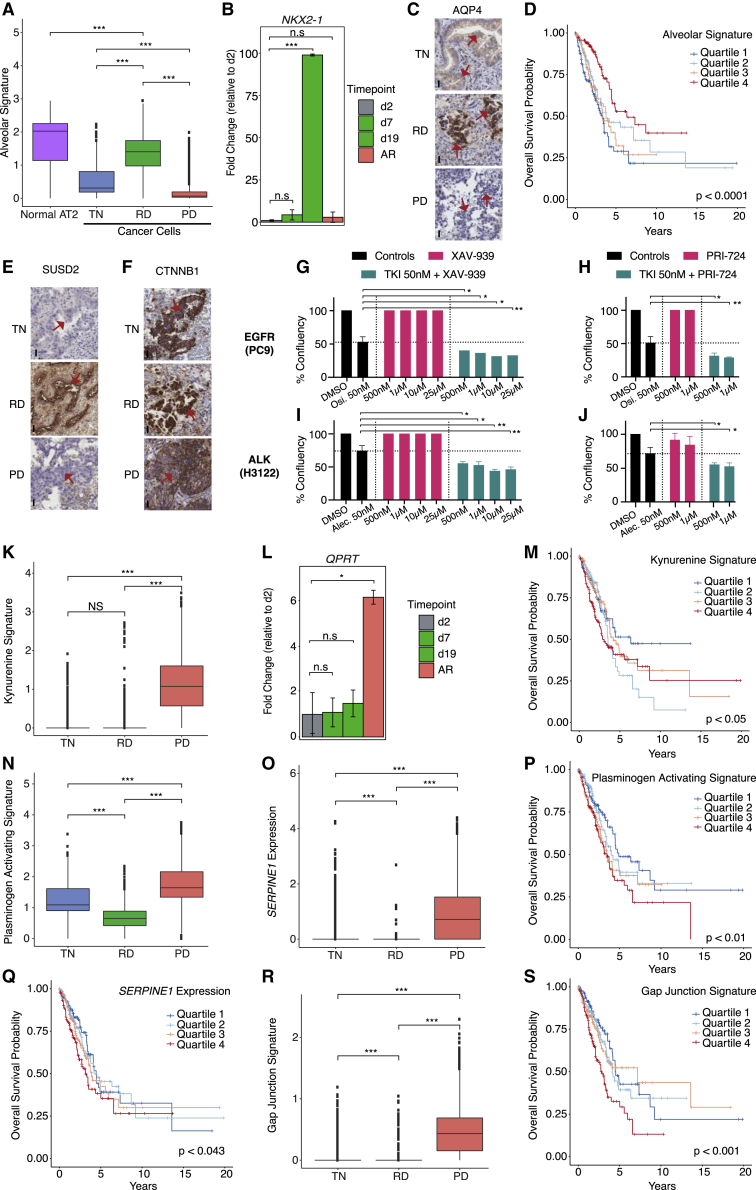
Differential Gene-Expression Analysis between Treatment Time Points Reveals Treatment Stage-Specific Transcriptional Signatures(A) Boxplots showing the expression level of the alveolar signature across treatment time points as well as non-cancerous AT2 cells from our cohort. ∗∗∗p < 0.001.(B) Fold-change expression of NKX2-1 as quantified by RT-PCR in EGFR mutant PC9 cells after specified treatment duration (see STAR Methods), ∗∗∗p < 0.001.(C) Representative IHC images of TN, RD, and PD tumor tissue sections stained for AQP4 demonstrating increased expression at the RD time point. Red arrows indicate cancer cells of interest. Scale bars correspond to 50 μm.(D) Kaplan-Meier plot of the relationship between the alveolar signature and patient OS within the TGCA dataset. Patients were stratified by signature expression quartile (Q1 = 128, Q2 = 127, Q3 = 128, Q4 = 127), where Q1 is the lowest expression and Q4 is the highest expression.(E and F) Representative IHC images of TN, RD, and PD tumor tissue sections stained for SUSD2 (E) and CTNNB1 (F) demonstrating increased expression at the RD time point. Red arrows indicate example regions of interest. Scale bars correspond to 50 μm.(G–J) Treatment response upon inhibition of β-catenin activity in EGFR mutant PC9 cells and ALK fusion-positive H3122 cells. Relative viability is shown as percent confluency compared to DMSO control. PC9 cells were treated with XAV-939 (G) or PRI-724 (H) with or without the combination of 50nM osimertinib. H3122 were treated with XAV-939 (I) or PRI-724 (J) with or without the combination of 50 nM alectinib. p values were calculated for all end points (day 6) values compared to single agent TKI. Error bars represent mean ± standard error of the mean (SEM), n = 4 technical replicates. ∗p < 0.05, ∗∗p < 0.01.(K) Boxplots showing the expression levels of the kynurenine signature expression across different treatment time points. ∗∗∗p < 0.001.(L) Fold-change expression of QPRT as quantified by RT-PCR in PC9 cells after treatment with osimertinib as in (B) (see STAR Methods) (AR), ∗p < 0.05.(M) Kaplan-Meier plot of the relationship between the kynurenine signature and patient OS within the TGCA dataset. Patients were stratified by signature expression quartile (Q1 = 128, Q2 = 127, Q3 = 128, Q4 = 127), where Q1 is the lowest expression and Q4 is the highest expression.(N) Boxplot showing the expression levels of the plasminogen activation pathway signature across different treatment time points.(O) Boxplot showing the expression levels of the SERPINE1 across different treatment time points.(P) Kaplan-Meier plot of the relationship between the plasminogen activating pathway signature and patient OS within the TGCA dataset, respectively. Patients were stratified by signature expression quartile (Q1 = 128, Q2 = 127, Q3 = 128, Q4 = 127), where Q1 is the lowest expression and Q4 is the highest expression.(Q) Kaplan-Meier plot of the relationship between SERPINE1 expression and patient OS within the TGCA dataset, respectively. Patients were stratified by signature expression quartile (Q1 = 128, Q2 = 127, Q3 = 128, Q4 = 127), where Q1 is the lowest expression and Q4 is the highest expression.(R) Boxplot showing the expression levels of the gap-junction signature across treatment time points.(S) Kaplan-Meier plots of relationships between the gap-junction signature and patient OS within the TGCA dataset. Patients were stratified by signature expression quartile (Q1 = 128, Q2 = 127, Q3 = 128, Q4 = 127), where Q1 is the lowest expression and Q4 is the highest expression.See also Figures S3, S4, and S5 and Tables S2, S4, S5, and S6.